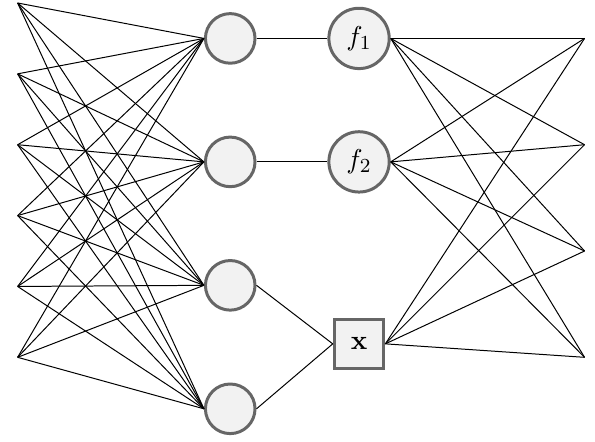
Figure 6 . A representation of a simple EQL layer with n m = 4 and n o = 3 sandwiched between two fully-connected layers. The (cid:12)rst two elements of the intermediate representation are each acted on by activation functions f i , while the remaining two elements are multiplied